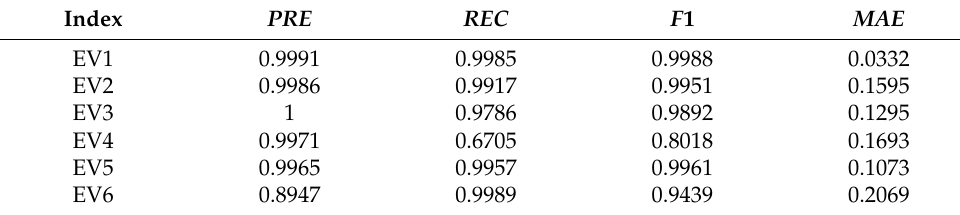
Table 1. Solving results of electric vehicle charging station with no new random load.